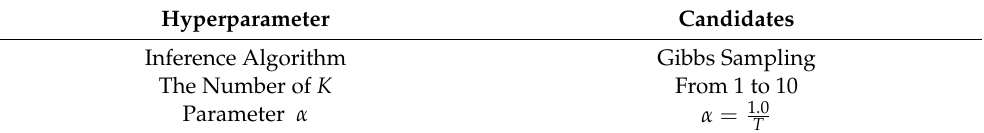
Table 3. Hyperparameters for the LDA model.